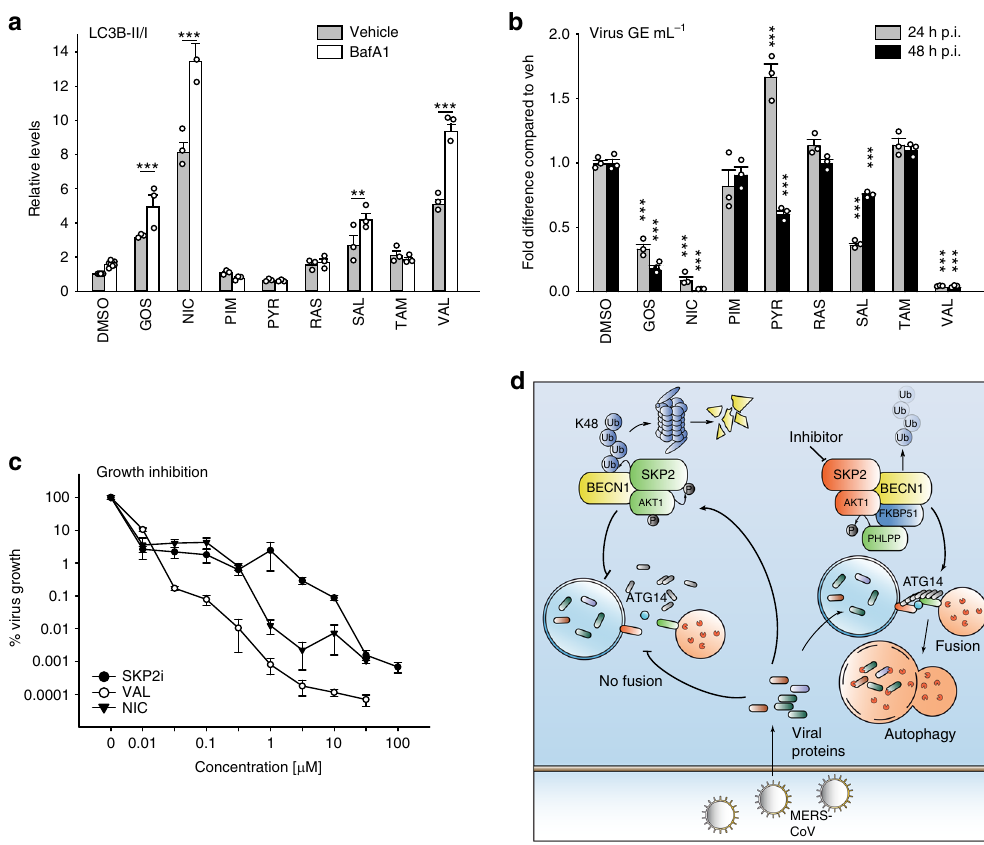
Fig. 9 Some potential SKP2 inhibitors affect autophagy and viral replication. a VeroB4 cells were treated with various FDA-approved drugs (for abbreviations and concentrations see Supplementary Table 3) and cotreatment with Ba fi lomycin A1 (0.1 μ M) was performed to evaluate the autophagic fl ux. The graph provides the means + SEM of three independent experiments, representative western blots are shown in Supplementary Fig. 8b. b VeroB4 cells were infected with MERS-CoV (MOI = 0.001), treated with the indicated drugs, and MERS-CoV genome copies were determined by RT-PCR 24 h and 48 h p.i.; data are presented as (log10) fold difference in relation to the DMSO control. Unprocessed data and PFU results are presented in Supplementary Fig. 9a – c. c Concentration-dependent inhibition of MERS-CoV replication by the SKP2-inhibitor (SKP2i), valinomycin (VAL) und niclosamide (NIC). VeroB4 cells were infected with MERS-CoV (MOI = 0.001) and treated with drug. MERS-CoV genome copies were determined by real-time RT-PCR at 48 h p.i., data present the percentage of remaining MERS-CoV genomes in comparison to vehicle treatment. In all panels, error bars denote the standard error of the mean, derived from n = 3 or n = 6 ( c , no drug condition) biologically independent experiments. ** p < 0.01, *** p < 0.001 (two-way ANOVA in a , one-way ANOVA in b , details in Supplementary Table 1). d Summary scheme: SKP2 leads to K48-linked poly-ubiquitination and thus degradation of BECN1.